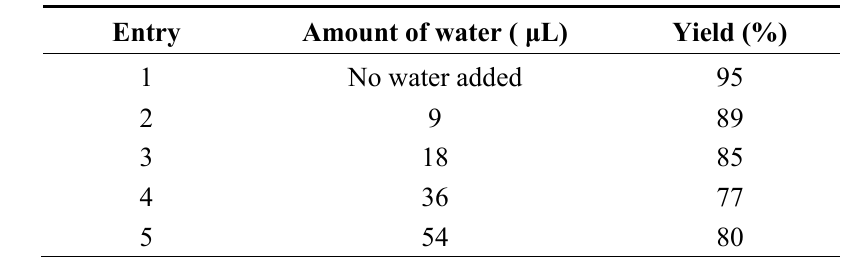
Table 3. Effect of the amount of water on the acetylation of 4-nitrobenzyl alcohol in ethyl